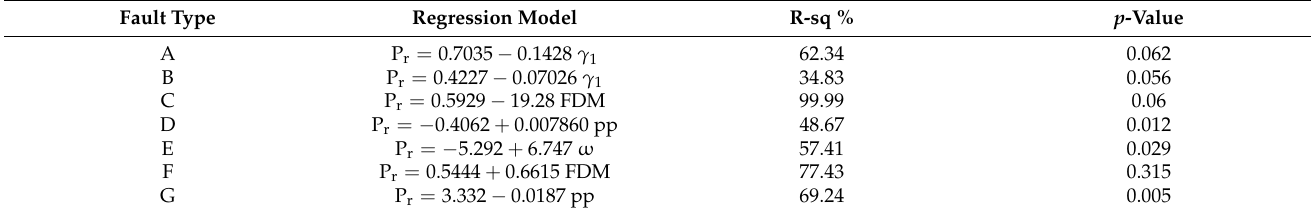
Figure 6. Regression analysis for correlation of operating power ratio for different types of faults. Table 5. Regression model parameters for different types of